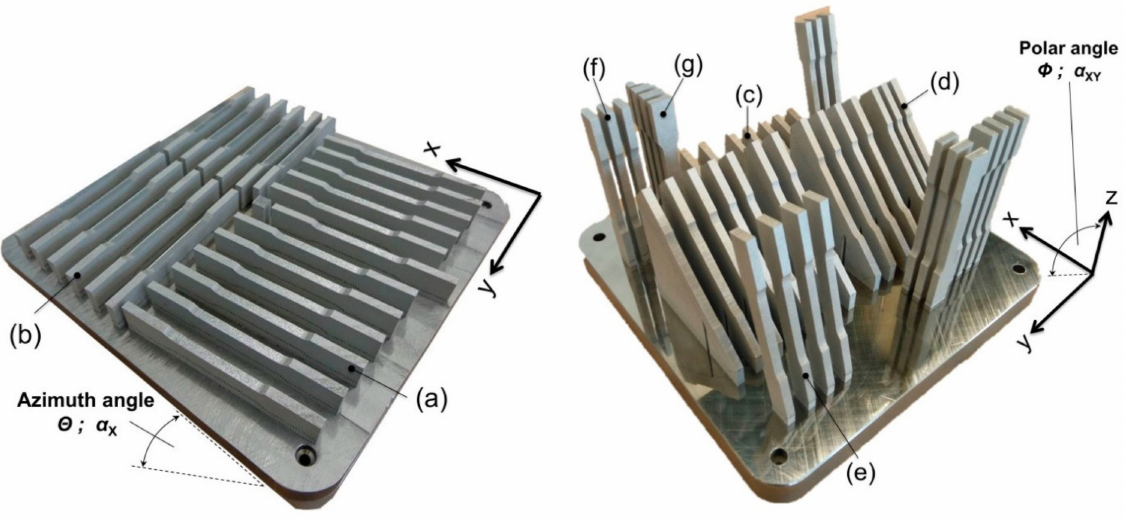
Figure 7. The tensile samples in 1.4404 (316L) on the building platform: overview of the positioning, building angles and arrangement (configurations). See also Tables 11 and 12. The figure is from